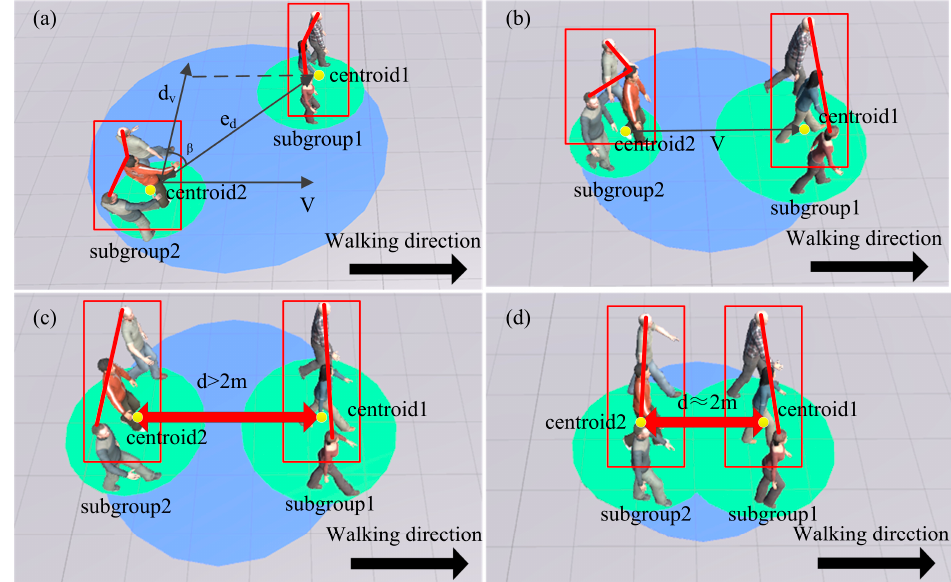
Figure 9. Simulation results of subgroups coordinate process. ( a ) Initial state; the distance between subgroups in the walking direction V and the direction perpendicular to V are 5 m. ( b ) Subgroup 2 tries to align with subgroup1 and d v = 0. ( c ) The distance between centroid1 and centroid 2 is more than 2 m, and subgroup 2 will speed up to catch up with subgroup 2. ( d ) The distance is approximately 2 m. Both subgroups will walk forward with a steady speed and